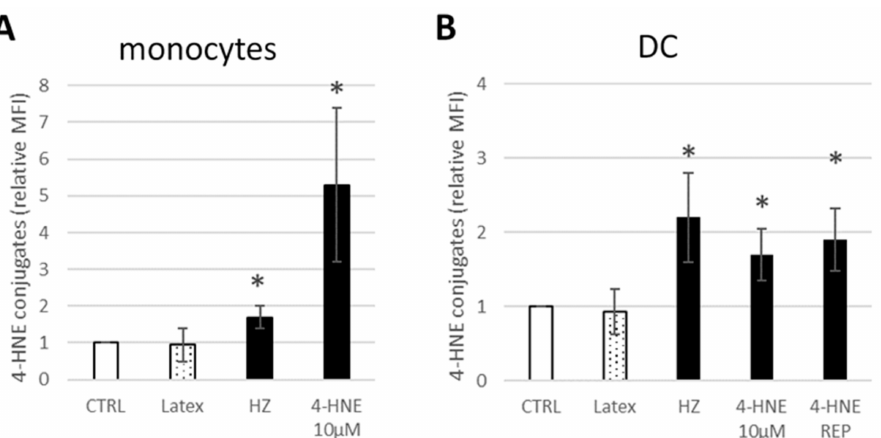
Figure 3. Increased levels of 4-HNE–protein conjugates on the surface of GM-CSF/IL-4-stimuIated, HZ-fed, or 4-HNE-treated monocytes and DC. Untreated control (CTRL), latex bead-fed (Latex) or HZ-fed (HZ) monocytes, or single dose 4-HNE-treated (4-HNE 10 µ M) or repeatedly with 1 µ M 4-HNE treated (4-HNE REP) monocytes were differentiated to DC during 7 days by stimulation with GM-CSF and IL-4 at 3 h after start of cell incubation and every following 48 h. 4-HNE conjugation was detected on the surface of GM-CSF/IL4-stimulated monocytes at 24 h after start of phagocytosis or 4-HNE treatment ( A ) or on differentiated DC at day 7 of differentiation ( B ) with specific anti-4- HNE-conjugate antibodies and quantified with FITC-labelled secondary antibody by flow cytometry. Fluorescence intensity of bound secondary antibody mirrors the 4-HNE- surface protein conjugation level and is plotted as mean fluorescence intensity (MFI), which was referred to MFI of control cells from the same donor. Means ± SE of 3 independent experiments with monocytes from 3 donors are shown in the figure. The significance of differences (* p < 0.01) between controls and HZ- or 4-HNE-treated cells is